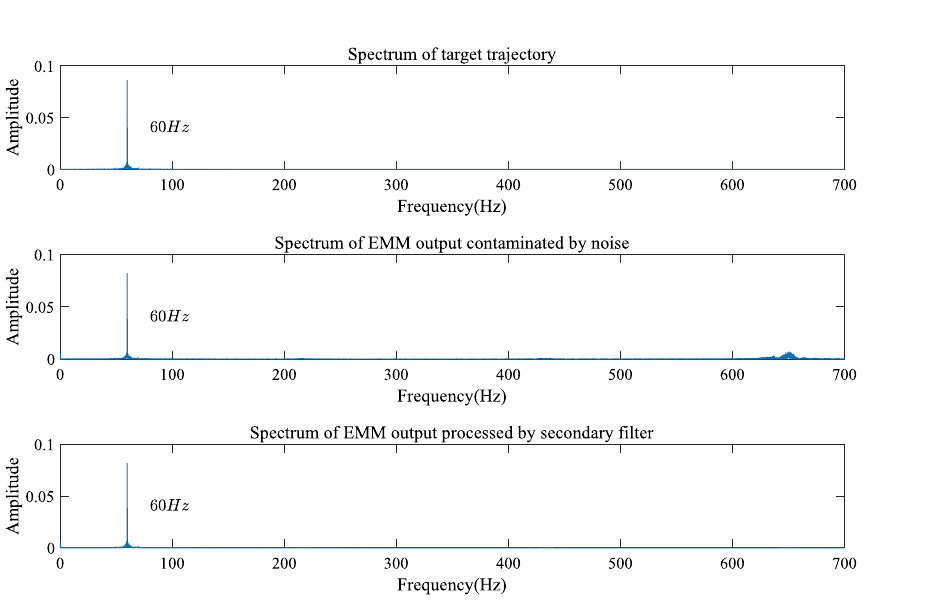
Figure 12. Spectrum analysis of the noise suppression using secondary